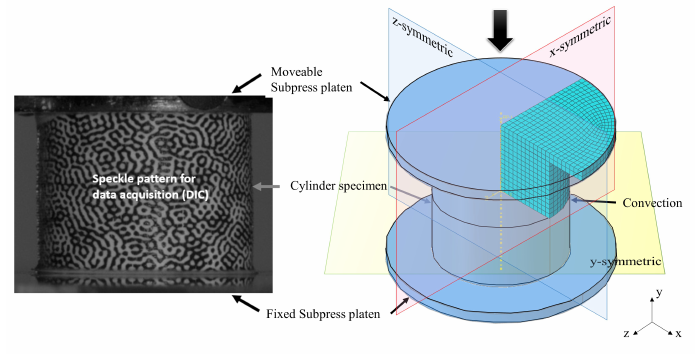
Figure 10. Cylinder specimen with friction-reducing sheets during high-speed compression ( left ) and one-eighth FE model with subpress platen ( right ).